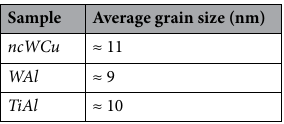
Table 1. Average grain size in the nc